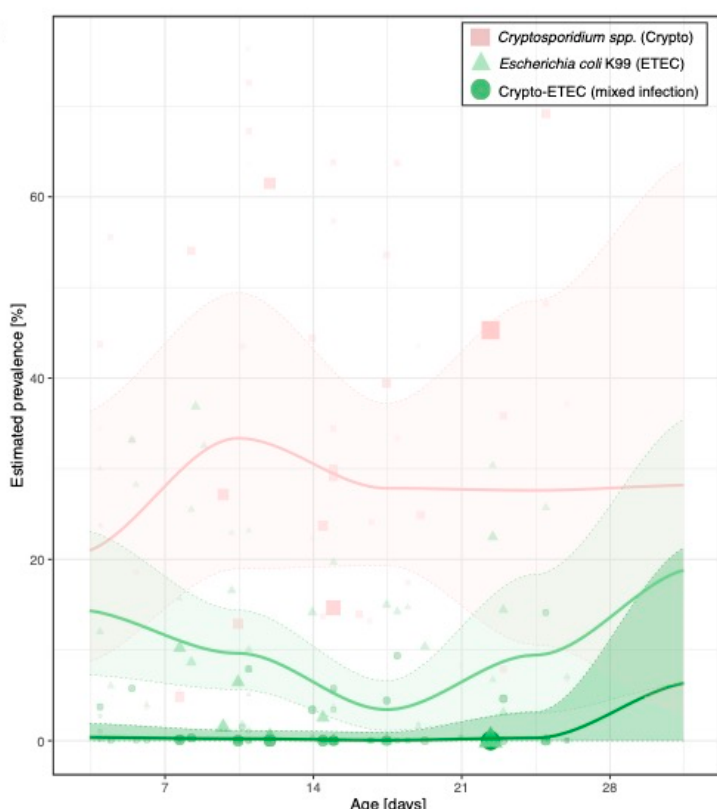
Figure 3. Cryptosporidium spp. (Crypto), ( a ) bovine rotavirus (BRV), ( b ) bovine coronavirus (BCoV), ( c ) Escherichia coli F5 (K99) (ETEC) prevalence and associated mixed infection with Crypto depending on the age of sampled animals until 30 days. The mean prevalence estimates of all incorporated studies are represented as lines with the corresponding 95% CI (area) and individual prevalence values of the studies during the period observed are presented as dot symbols. The wider the dot symbols are the more prevalence estimates at a certain age group of sampled animals are available.